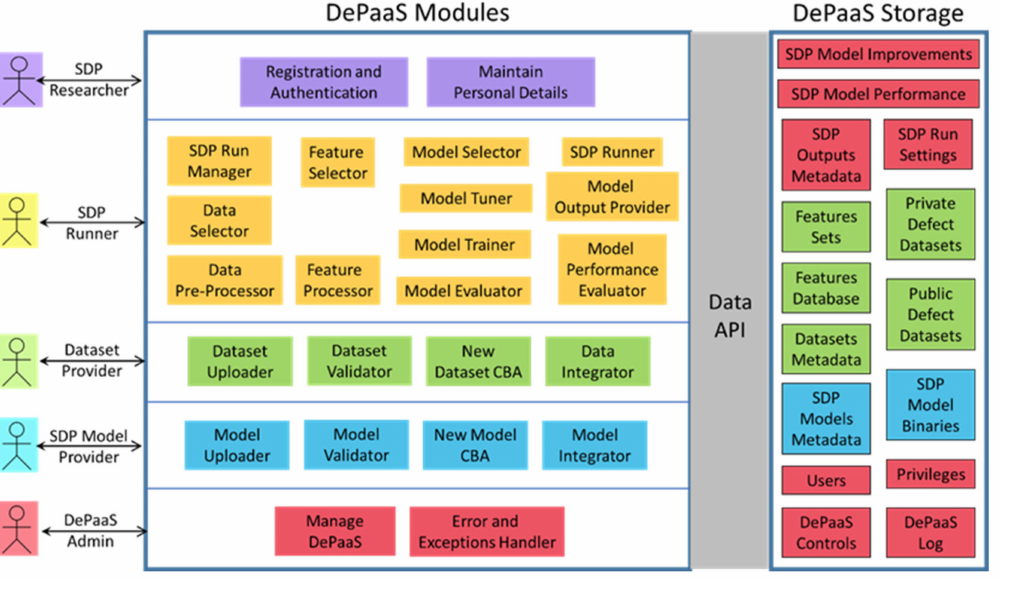
Figure 2. Layered, Modular Architecture of